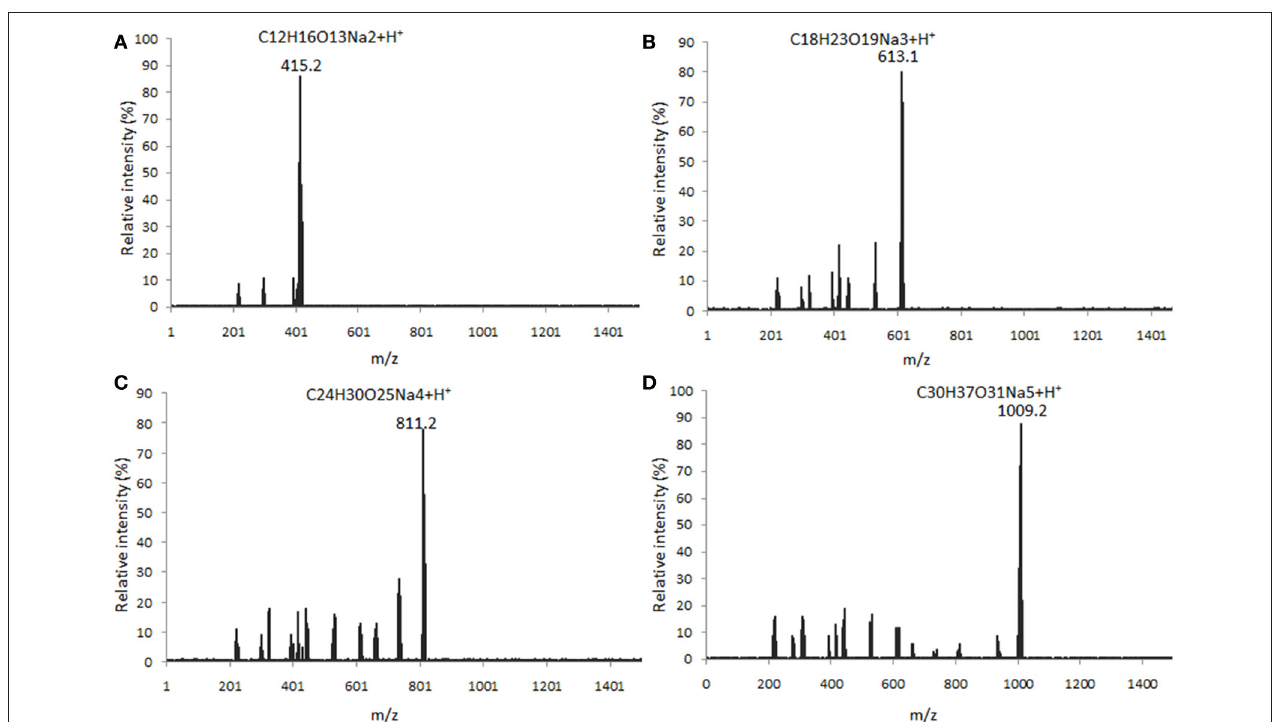
FIGURE 2 | ESI MASS spectrometry analysis of the polymer degrees of digested AOS from alginate sodium under the conditions that produced mass spectra with M + H + . (A) mass spectra were visualized following the separation of DP2 ([M + H] + = 415 Da); (B) mass spectra were visualized following the separation of DP3 ([M + H] + = 613 Da); (C) mass spectra were visualized following the separation of DP4 ([M + H] + = 811 Da); and (D) mass spectra were visualized following the separation of DP5 ([M + H] + = 1,009 Da).